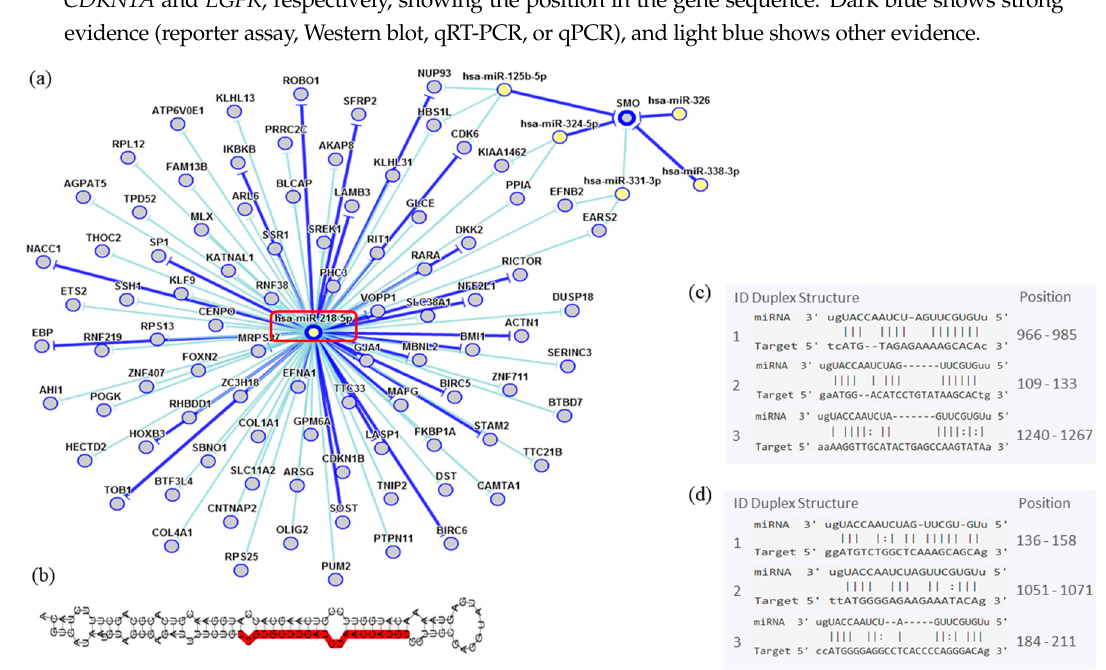
Figure 10. Interaction network of miR-218-5p. ( a ) The mRNA showed a strong modulation of CDKN1A and an indirect interaction with SMO . ( b ) Molecular structure: pre-miRNA hairpin of miR-218-5p, second structure of pre-miRNA, and, in red, mature sequence 25|UUGUGCUUGAUCUAACCAUGU|45. ( c , d ) miRNA sequence of target interactions with CDKN1A and SMO , respectively, showing the position in the gene sequence. Dark blue shows strong evidence (reporter assay, Western blot, qRT-PCR or qPCR), and light blue shows other evidence.